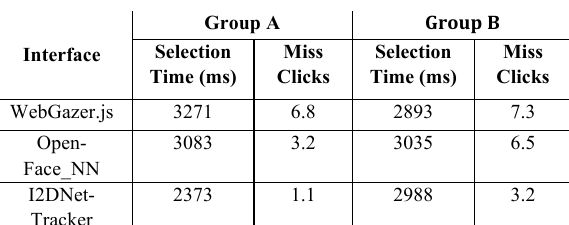
Table 3: Selection Time and Miss clicks comparison between participants with and without